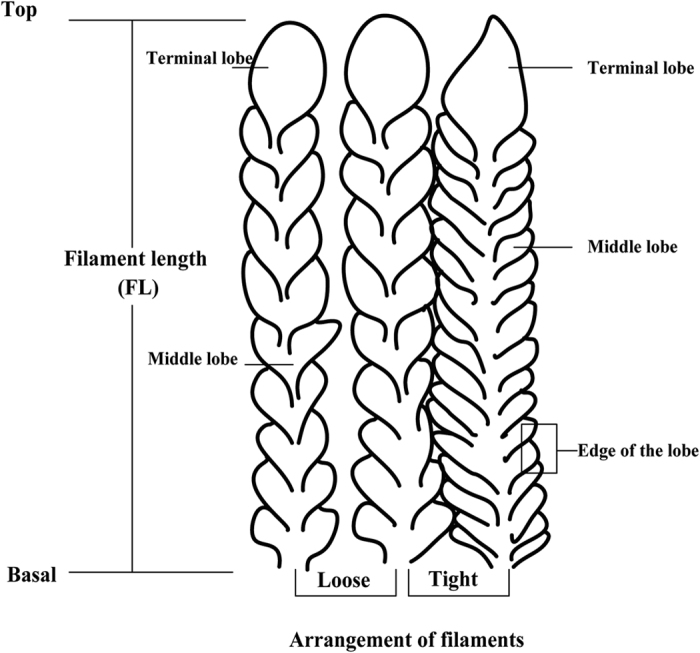
Diagram of part of gill raker of Mobulid ray, showing morphology and arrangement of gill filaments and secondary lamellae.